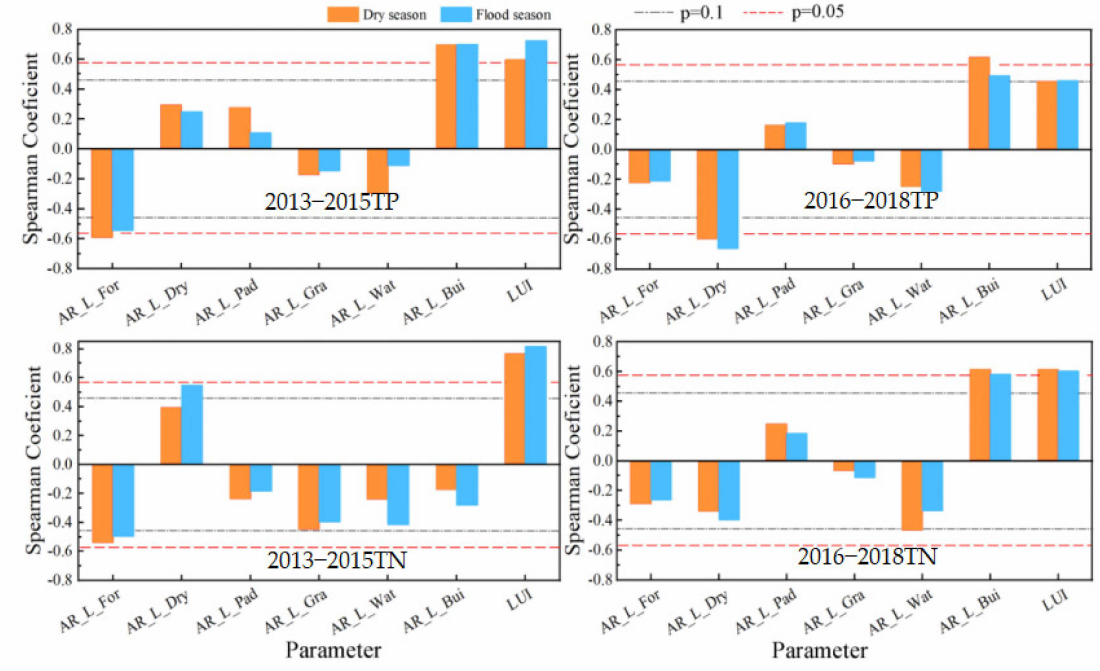
Figure 13. Correlations between land use structure and TP and TN